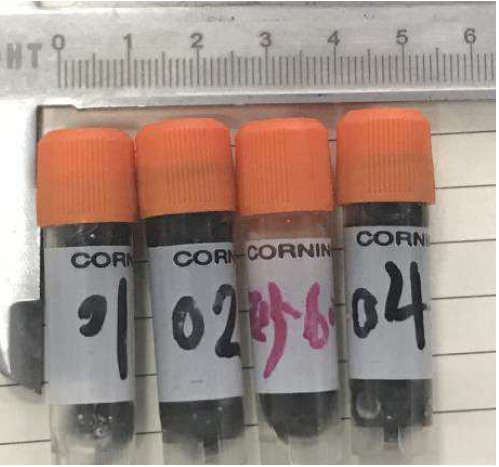
Figure 1. Paste and mortar samples encased in epoxy resin after mercury intrusion.